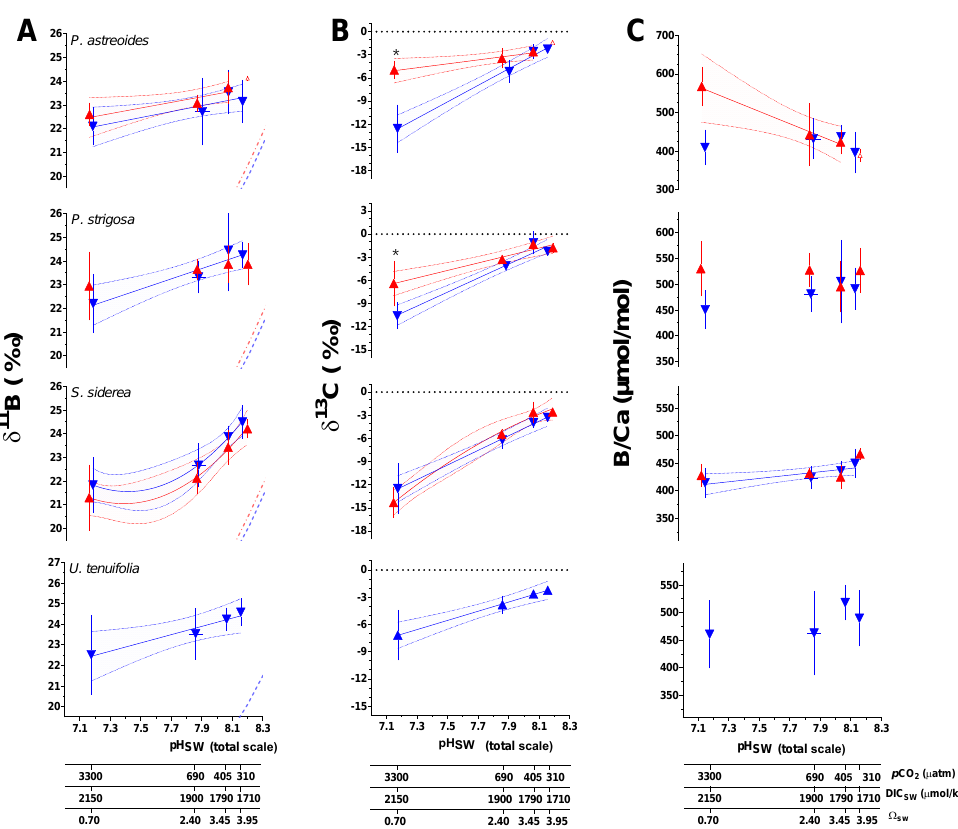
Figure 2. Measured δ 11 B ( A ), δ 13 C ( B ), and B/Ca ( C ) composition of coral aragonite following the 93-day culturing experiment. Large triangular symbols represent the mean value ( ± 1SD) for each treatment condition. Blue symbols represent the control temperature (28 ◦ C) treatment condition and red represents the high temperature (31 ◦ C) treatment condition. Linear versus centered quadratic fit was determined using the Akaike’s Information Criteria test (Table S8), with shaded areas representing the 95% confidence interval. Dashed blue and red curves represent the expected δ 11 B composition of borate ion (B(OH) 4 − ) in solution at 28 ◦ C and 31 ◦ C, respectively. * indicates a significant difference between 28 ◦ C and 31 ◦ C data for a given p CO 2 treatment as demonstrated by a p -value < 0.05 in a Welch’s T